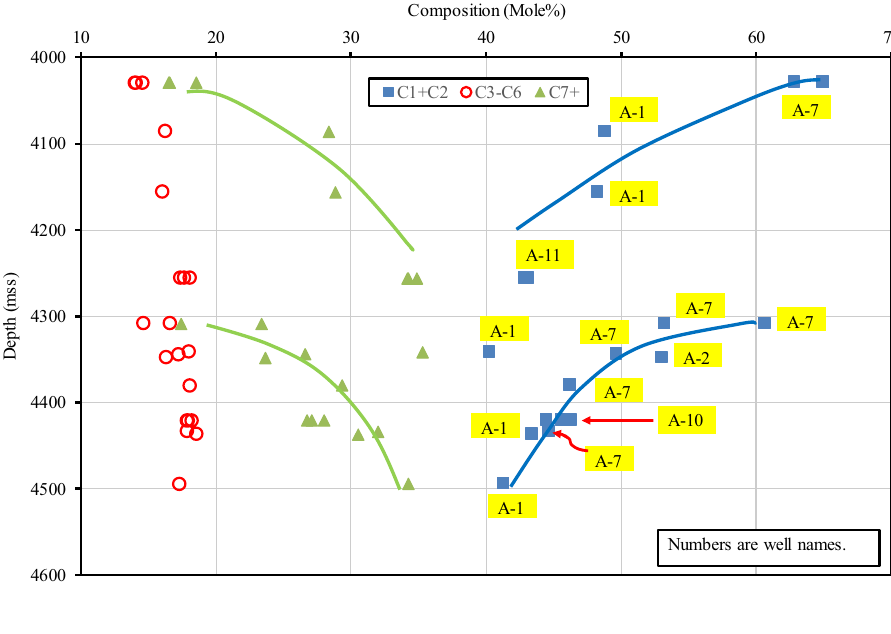
Fig. 6 Vertical reservoir fluid distribution (weight percent, three